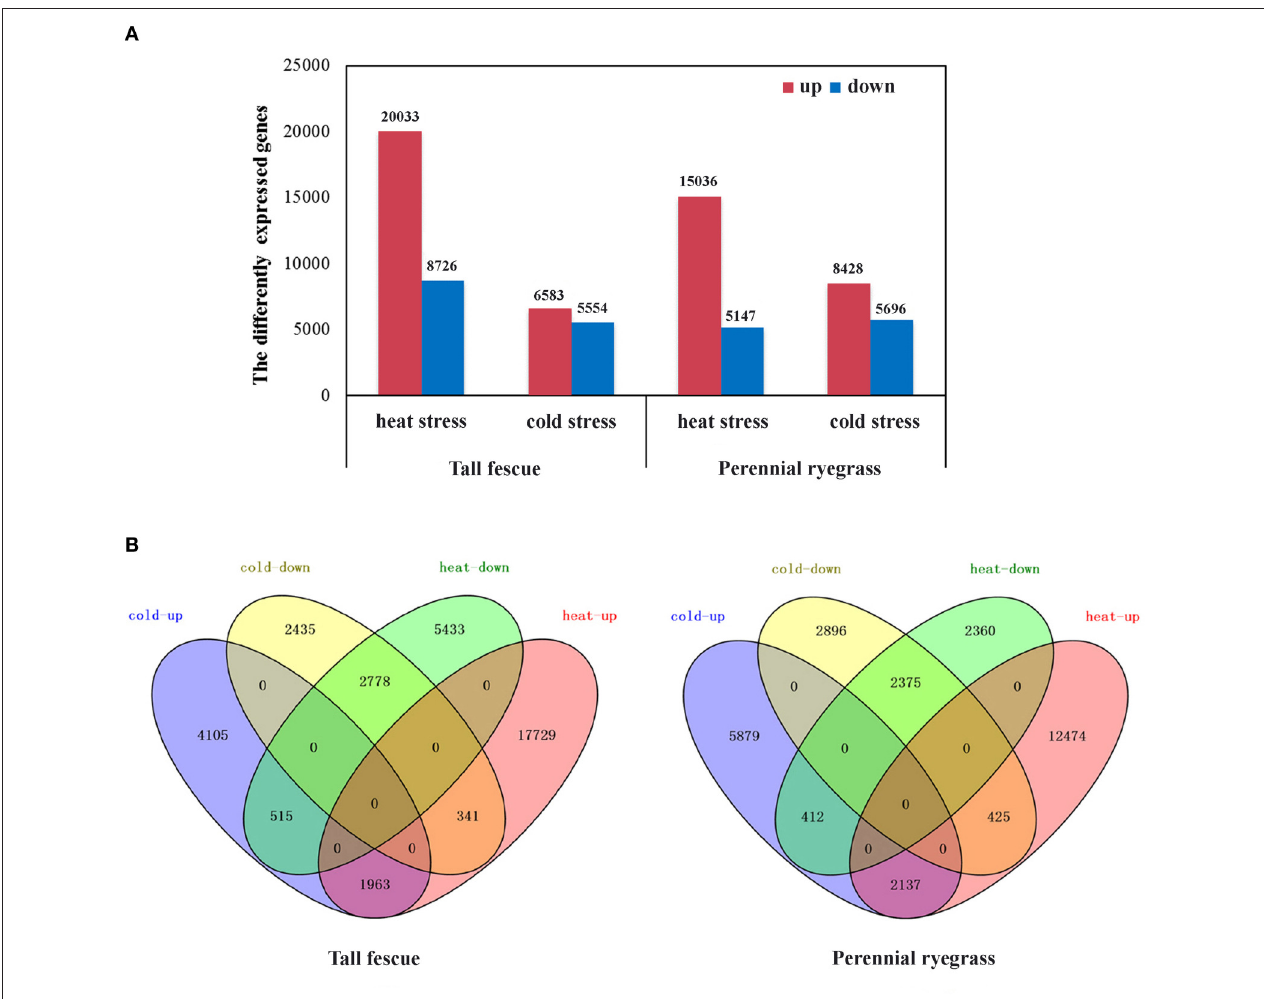
FIGURE 1 | Analysis of differentially expressed genes (DEGs) in tall fescue and perennial ryegrass transcriptomes in response to heat and cold stress. (A) Up- and down-regulated DEGs under heat or cold stress in the two grass species. Up (red) indicates upregulated DEGs, and down (blue) represents downregulated DEGs. (B) Shared and divergent DEGs in the tall fescue or perennial ryegrass under heat and cold stress. Heat-up (red) indicates the upregulated DEGs under heat stress; heat-down (green) represents the downregulated DEGs under heat stress; cold-up (blue) denotes the upregulated DEGs under cold stress; and cold-down (yellow) represents the downregulated DEGs under cold